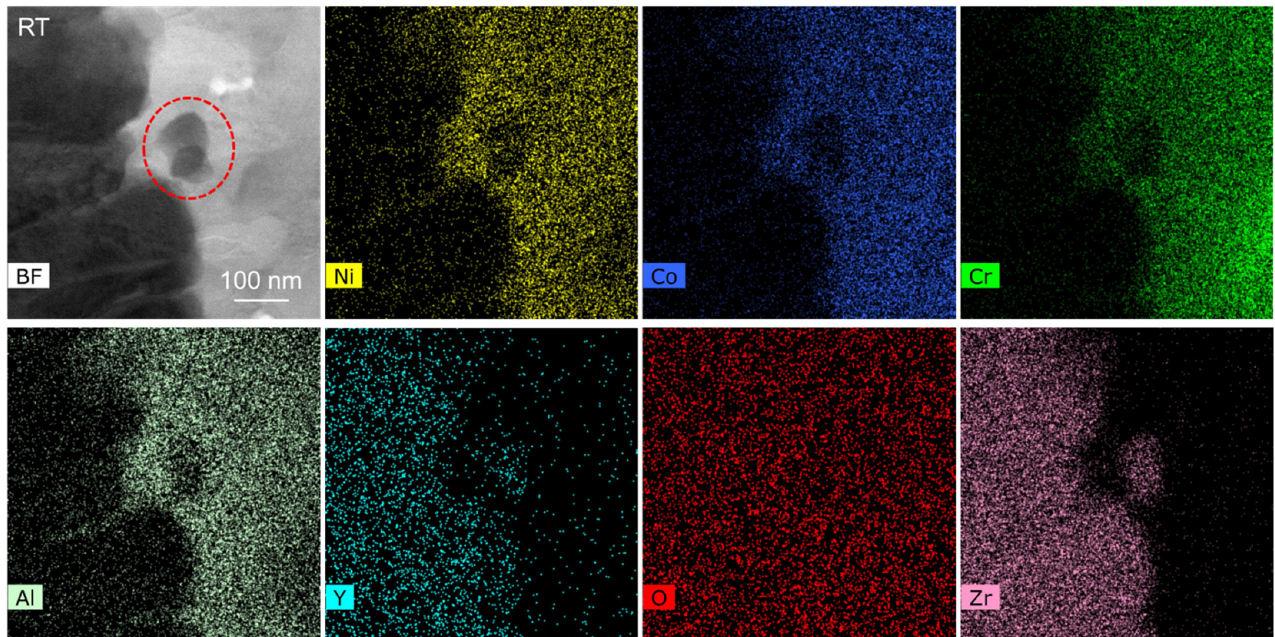
Figure 7. STEM-EDS maps of region 1 in Figures 3 and 4.